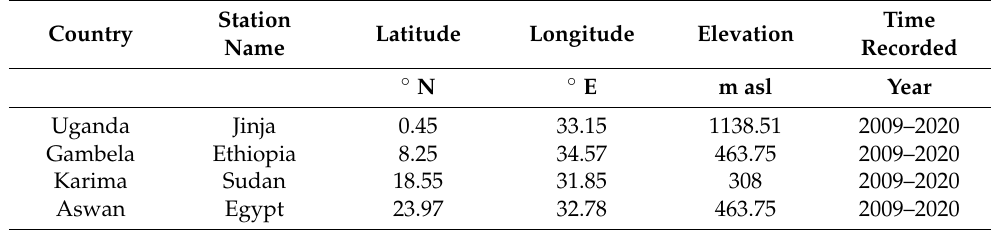
Table A1. Country, meteorological station name, latitude, longitude, elevation, and time